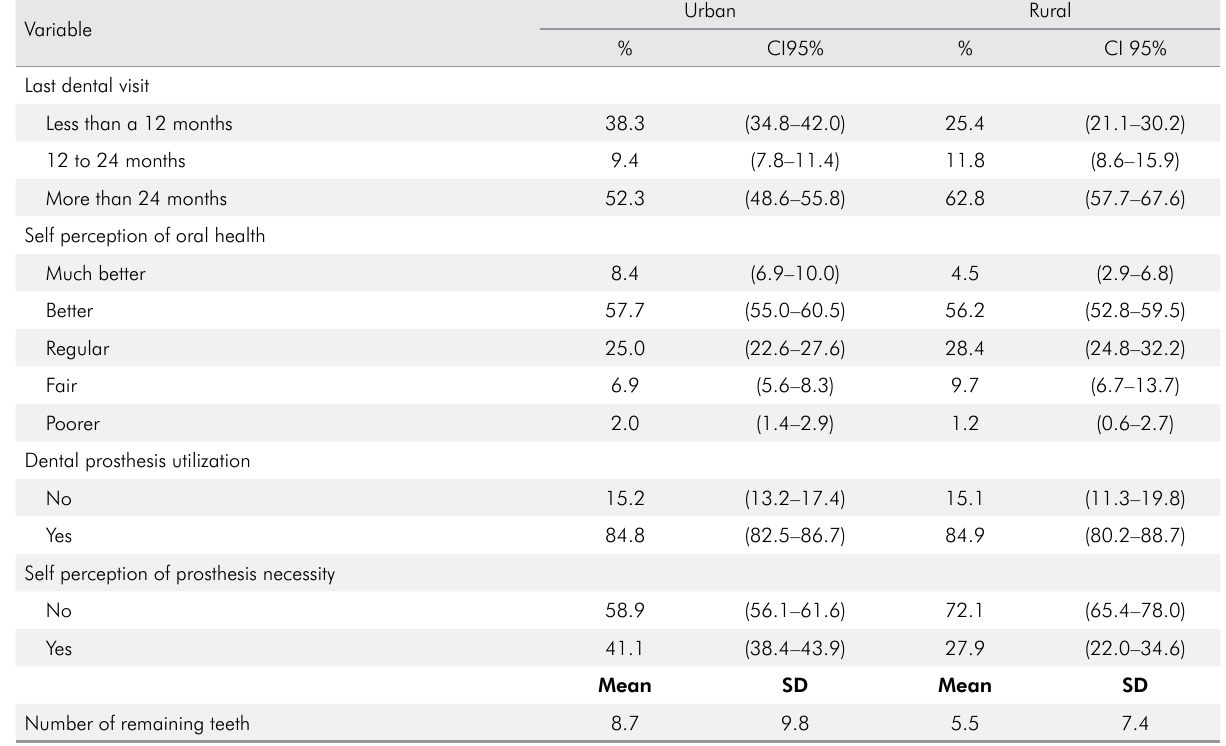
Table 2. Oral health characteristics of the sample.